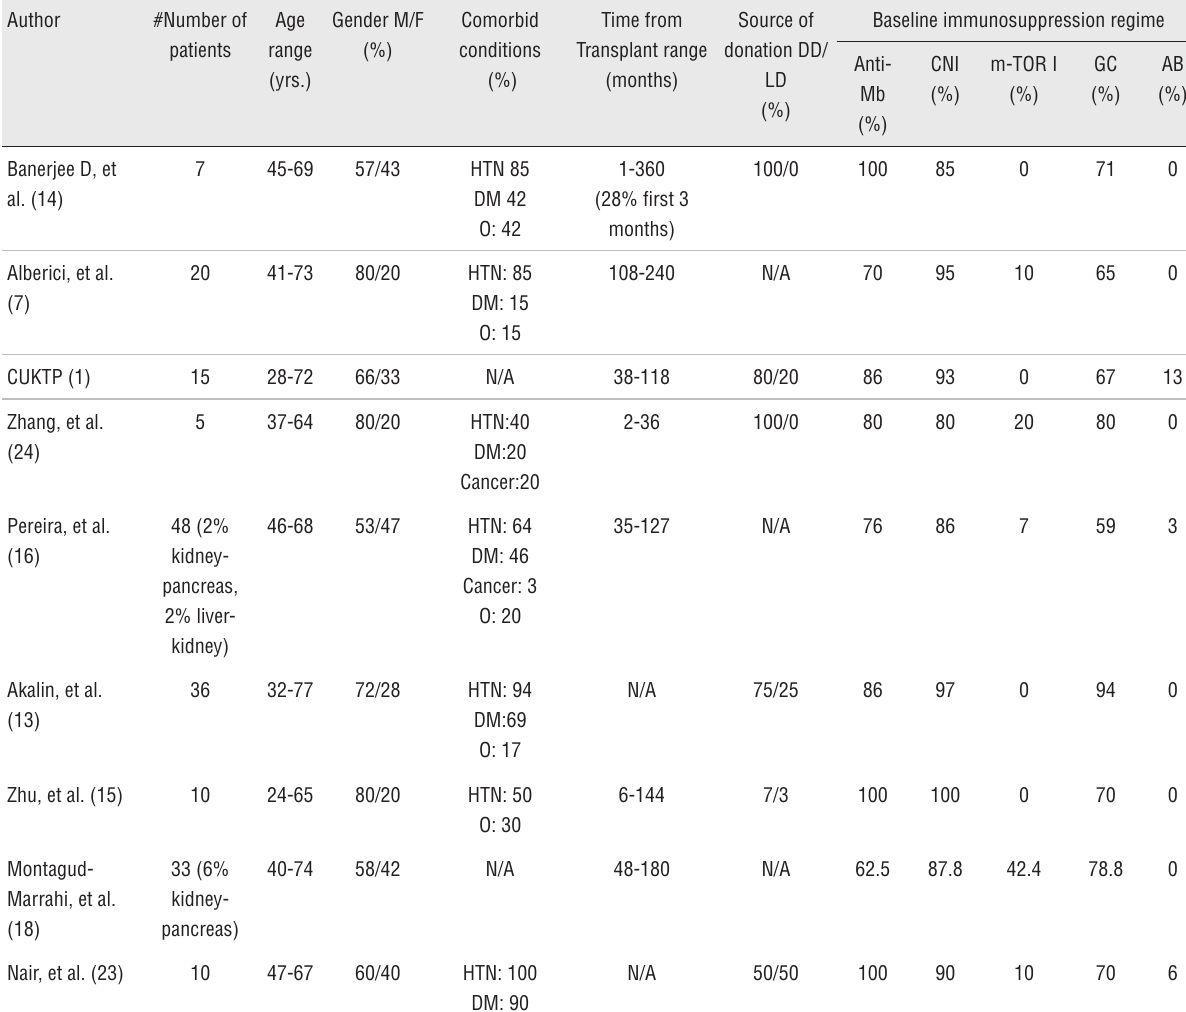
Table 1. Summary of demographics, comorbid conditions, time from transplantation, source of donation, and baseline immunossuppression